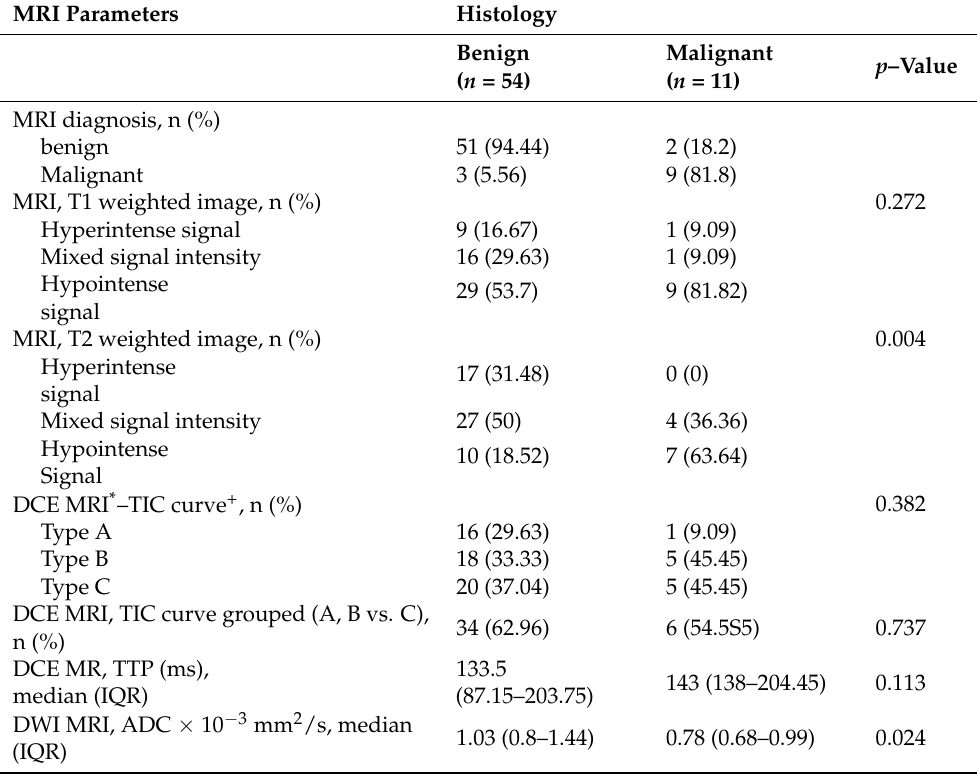
Table 3. Multiparametric MRI parameters—comparison between benign and malignant parotid tumors. MRI